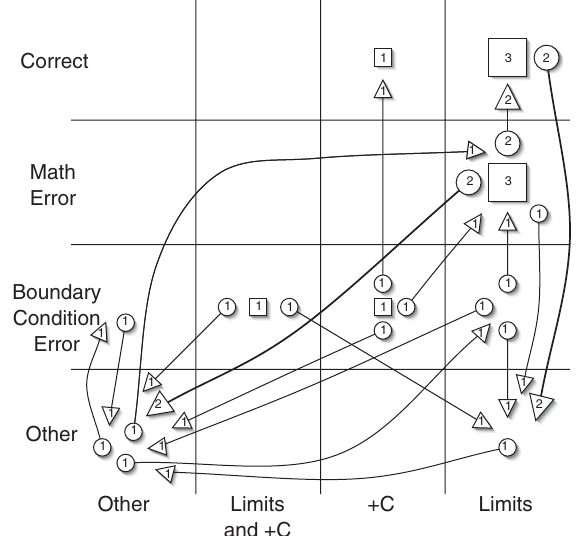
FIG. 7. Consistency plot showing changes in student midterm performance and final exam responses to identical questions in both years 1 and 3. Note that year 1 students had a midterm exam and year 3 students answered questions individually after engaging in a group quiz. Final exam questions were identical.